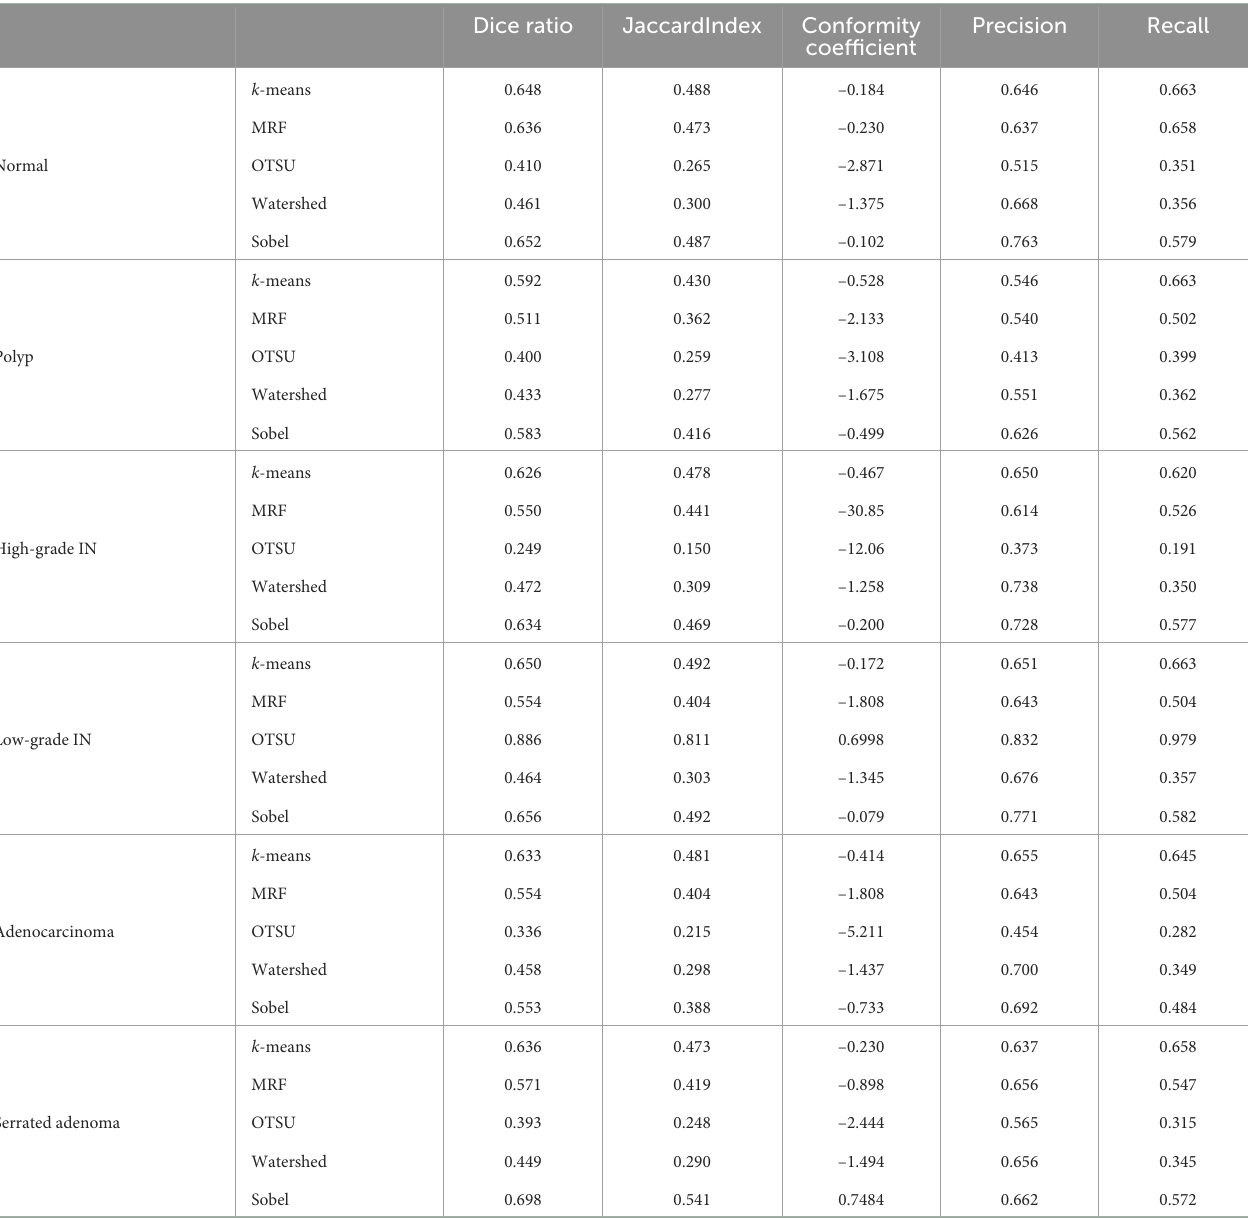
TABLE 3 Evaluation metrics for five different segmentation methods based on classical machine learning.